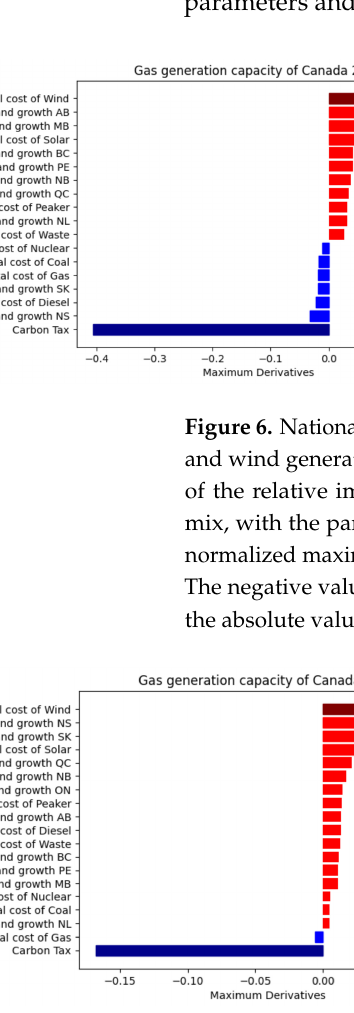
Figure 8. National Gas and Wind Generation Capacity in 2050. Ranked factors affecting Canadian gas and wind generating capacities in 2050 are presented in bar charts. These are quantitative measures of the relative impact of system inputs on two key components of the Canadian energy supply mix, with the parameters listed on the y -axis. These values, which show correlation intensity, are normalized maximum derivatives of gas and wind capacities with respect to each input on the y -axis. The negative values show the negative correlations, positive values show positive correla- tions, and the absolute values of maximum derivatives represent the correlation intensity. The results reinforce the previously mentioned findings that the most influential de- terminants of Canadian electricity system outcomes between now and 2050 are the carbon tax and the capital cost of wind. The capital cost of wind plays a particularly significant role, exhibiting a relative impact on the expansion of gas and wind capacities four times as large as any other technology cost. The results show that across all time steps, changes in other demand growth and non-wind energy technology cost parameters have minimal effects on the development of wind and gas generation capacities. 4. Discussion We find that there is a broad array of holistic insights we can draw from this surro- gate model by clustering or by ranking each correlation, and then comparing these rela- tionships across years, provinces, or parameters. The results confirm the effectiveness of policies such as carbon pricing and wind subsidies and highlight their significance com- pared to other options. The remainder of the analysis will focus on the most notable find- ings from national-level results.